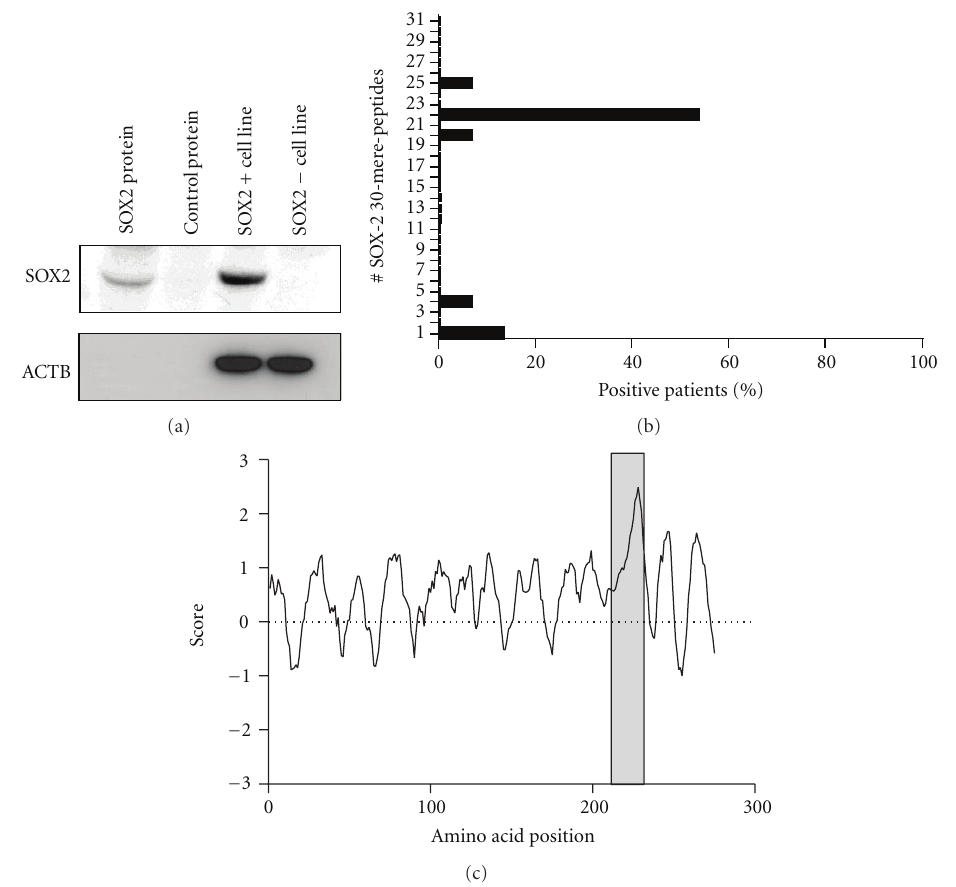
Figure 3: (a) Analysis of specificity of the SOX2 targeted IgG antibody response. Serum from a patient found positive by ELISA was used for western blot analysis and specifically recognized recombinant SOX2 and SOX2 from a SOX2-positive cell line (U266). In contrast, GST and a SOX2-negative cell line (DLD1) remained unstained. ACTB was used as loading control. (b) Mapping of the epitopes of target of the SOX2-specific antibody response in MM patients. Overlapping 20mer peptides ( n = 31) spanning the complete SOX2 sequence were used. Percentages of SOX2-antibody-positive patients for each epitope are given on the x -axis. Three patients recognized two or three epitopes. 8 patients had SOX2-specific antibodies only directed against the 20mer 22 (amino acids 211–230), and the antibodies of five patients did not recognize any of the 20mers that were used. (c) Epitope prediction of the antibody response for the whole SOX2 protein sequence using a hidden Markov prediction model. For each region probability scores are calculated. The grey area represents the main 20mers of target by the SOX2 antibody response in MM